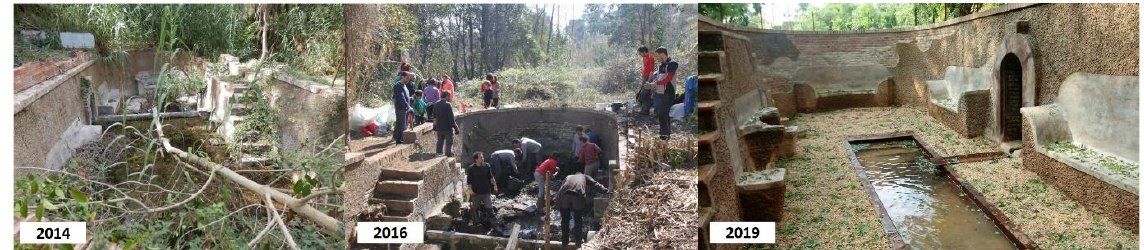
Figure 2. The spring of Can Moritz when first cleared of vegetation in 2014, during reconstruction in 2016 and after the restoration was completed in 2019 (pictures from Jordi Simó and Jordi Muntan).